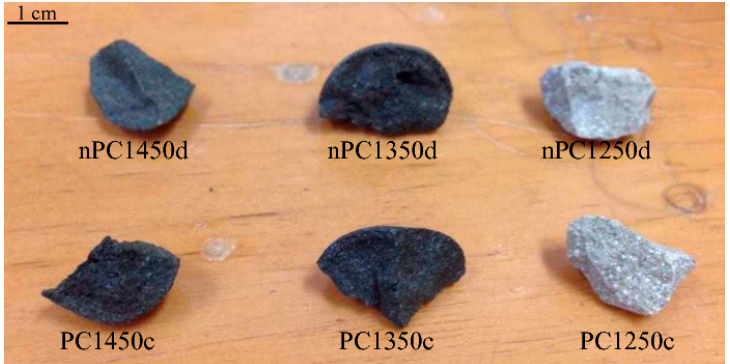
Figure 3. Clinkers after